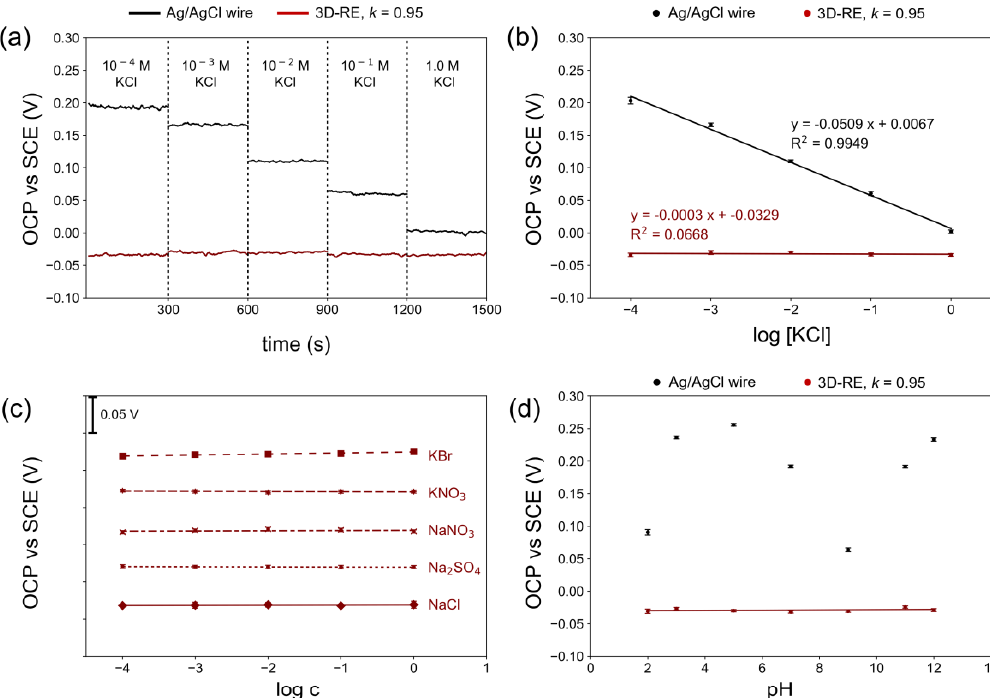
Figure 8. Potential stability of 3D-RE ( k = 0.95) and a Ag | AgCl wire pseudoreference electrode in various sample matrices. ( a ) Open-circuit potential (OCP) measurements over time with KCl concentration varied after every 5 min. ( b ) Nernst plot showing OCP dependence on the logarithm of KCl concentration. ( c ) Nernst plots showing 3D-RE OCP dependence on the logarithm of concentration of different electrolytes. Plots are offset by 0.05 V between each plot for clarity. ( d ) OCP responses at different pH. In ( b – d ), data are plotted as the mean of measurements from three electrode replicates ± the standard deviation.